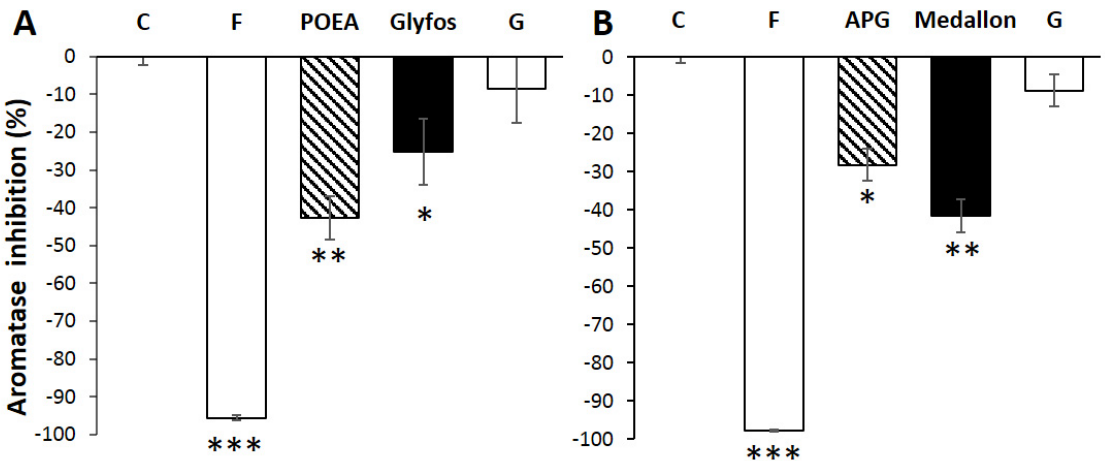
Figure 4. Aromatase inhibition by formulations and their co-formulants alone at similar levels. * p < 0.05, ** p < 0.01, *** p < 0.001. ( A ) 25 ppm of Glyfos is compared to the content in POEA (2.5 ppm) and glyphosate (16 ppm); ( B ) 300 ppm of Medallon is compared to the content in APG (120 ppm)